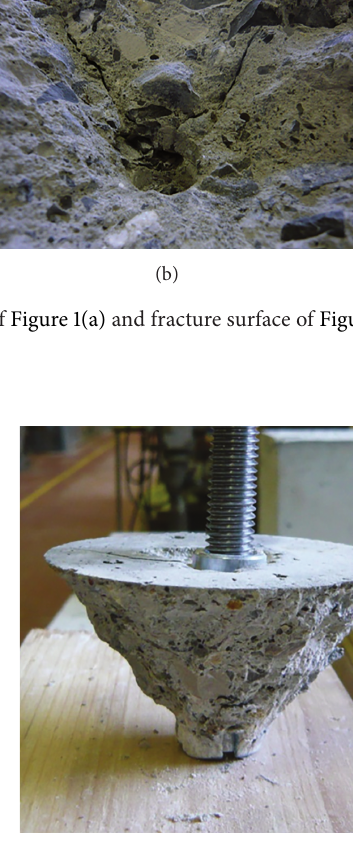
Figure 7: Extracted cone by the B15G